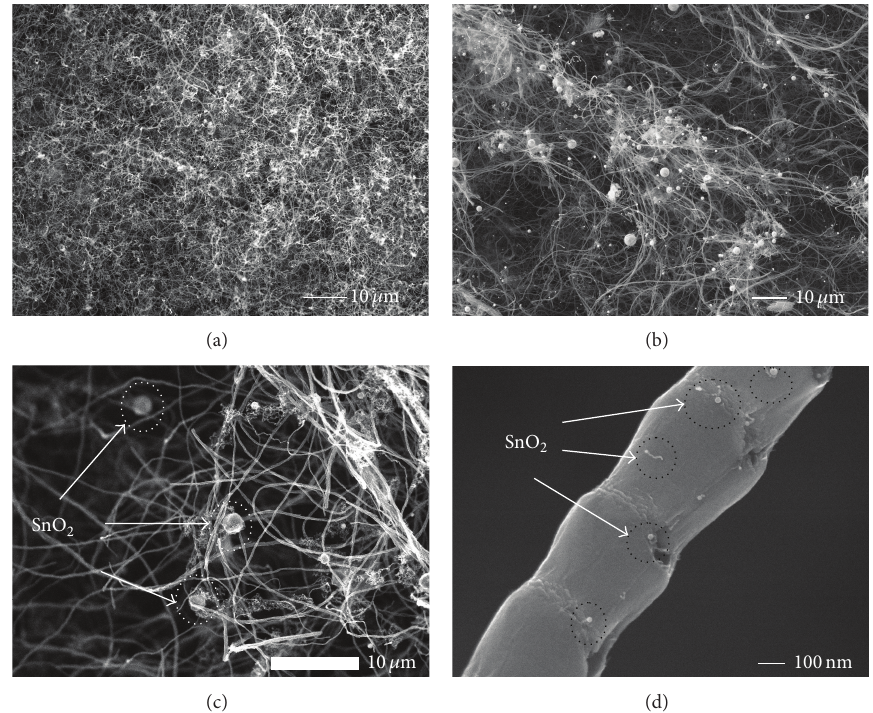
Figure 1: Field emission scanning electron microscopy images of (a) CNT alone and (b)–(d) SnO 2 -CNT composite. Circles in figures (c) and (d) indicate the location of the SnO 2